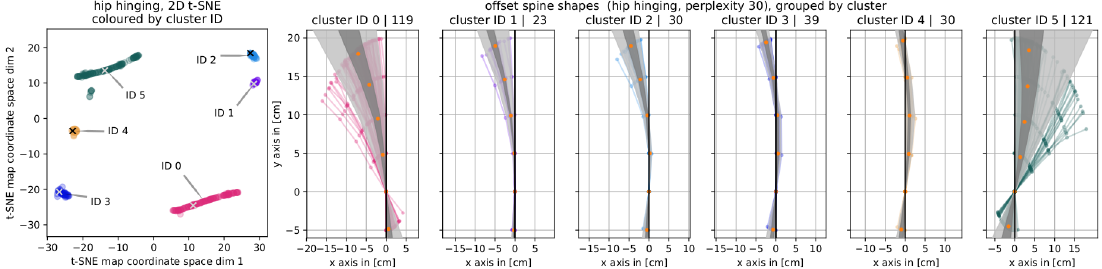
Figure A5. Results for clustering posture pairs of hip hinging . ( left ) The t-SNE map colored by cluster ID. An ‘x’ marks the position of a cluster representative. ( right ) Corresponding cluster bundles of offset spine shapes